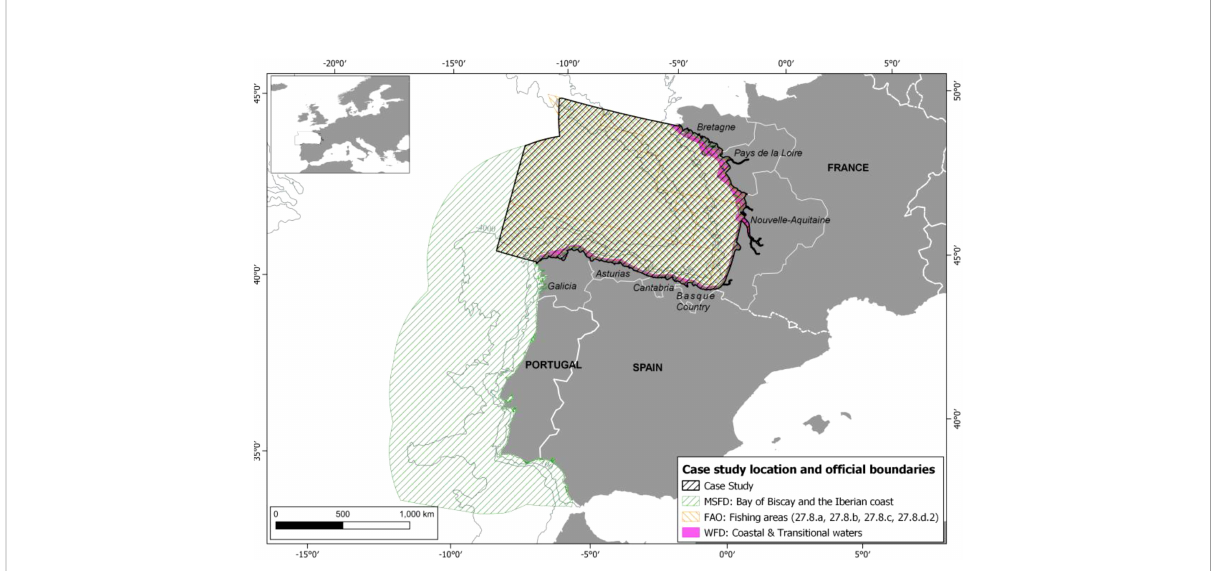
FIGURE 1 Location and geographic extension of the case study (Bay of Biscay), in the European context and other boundaries: Marine Strategy Framework Directive (MSFD), Food and Agriculture Organization (FAO) fi shing areas, and Water Framework Directive